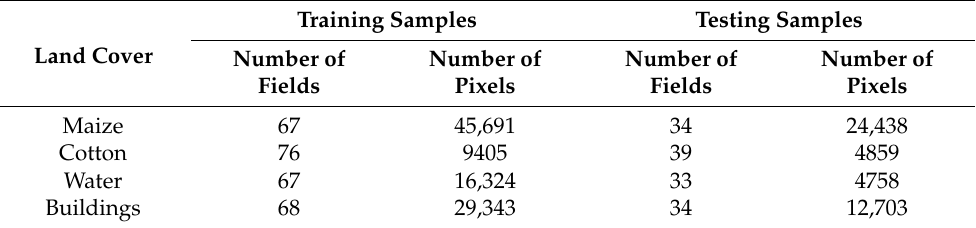
Table 2. Field data collected and the numbers of pixels used for classification training and